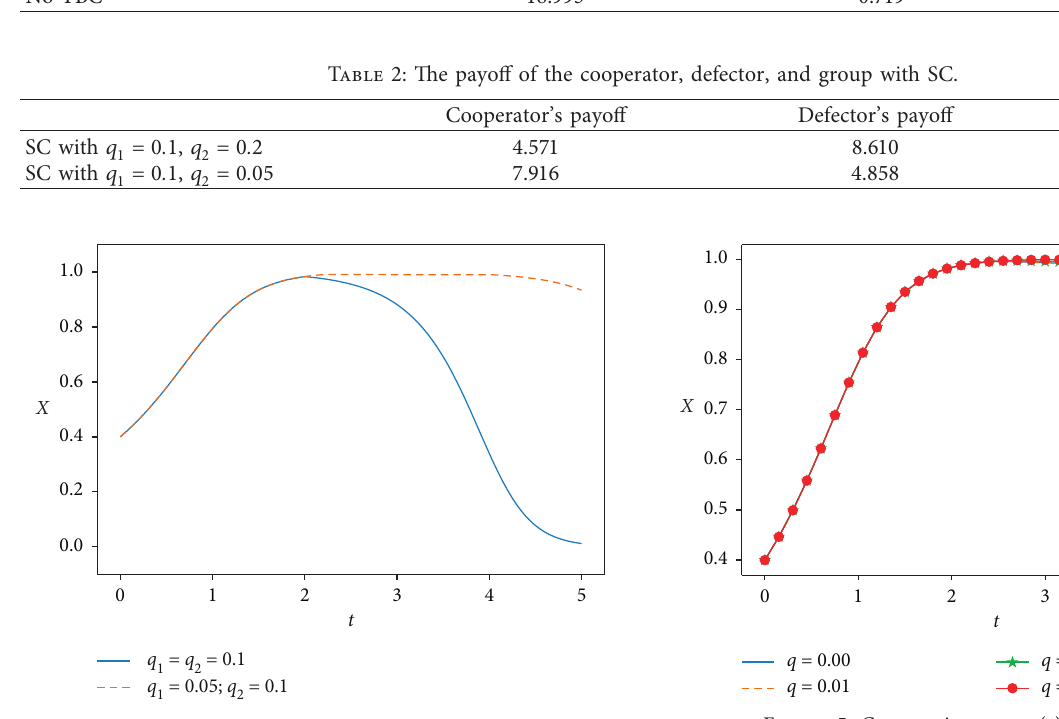
Table 1: Payoffs of the cooperator, defector, and group under different. q